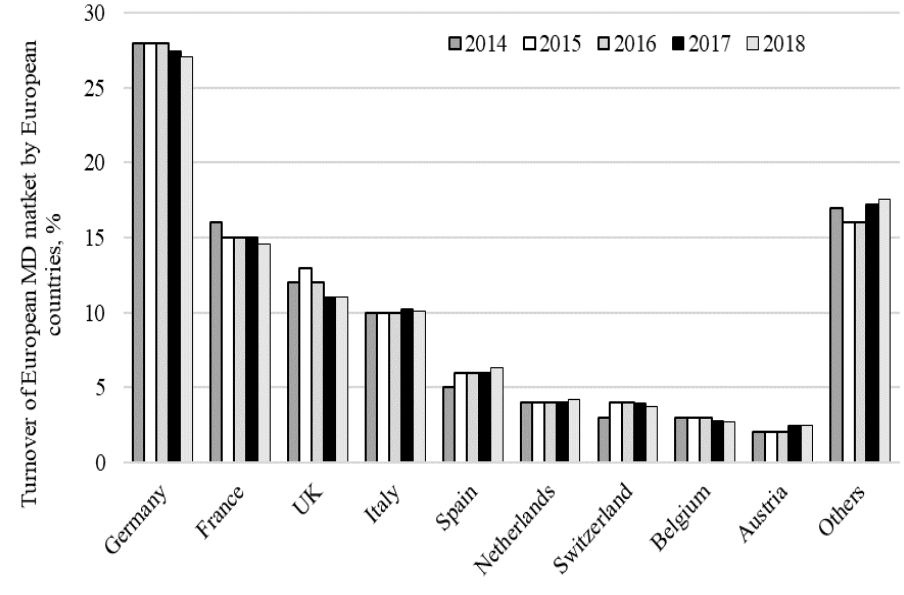
Fig. 2. The main players on the European MD market (developed by the author based on MedTech Europe